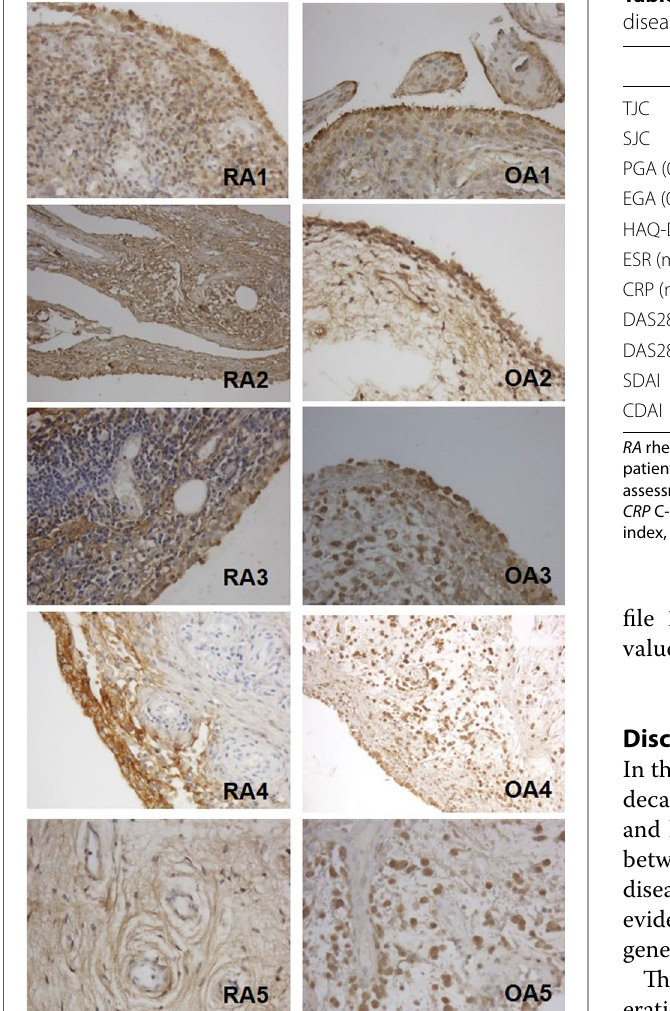
Table 2 The correlation of serum syndecn-4 concentration